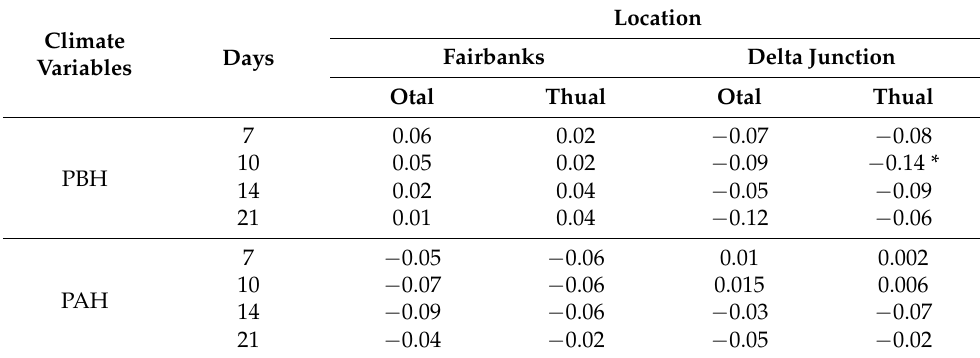
Table 2. Trends of drought days during 7, 10, 14, and 21 days BH and AH of ‘Otal’ and ‘Thual’ from 1991 to 2018 in Fairbanks and Delta Junction from 1992 to 2014. Location Climate Fairbanks Delta Junction Days Variables Otal Thual Otal Thual 7 0.06 0.02 − 0.07 − 0.08 10 0.05 0.02 − 0.09 − 0.14 * PBH 14 0.02 0.04 − 0.05 0.01 0.015 0.006 14 − 0.09